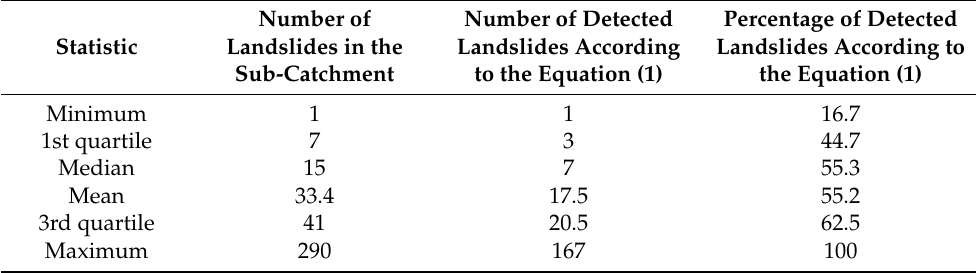
Table 1. Descriptive statistics for the performance of the simple normalized empirical rainfall threshold (Equation (1)).